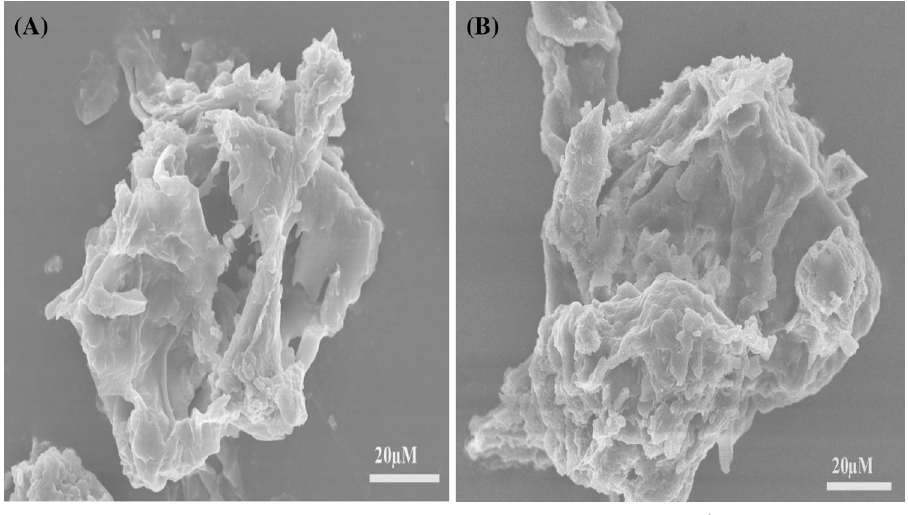
Fig. 7 Scanning electron micro- graphs of pristine and DR5B- loaded spent mushroom